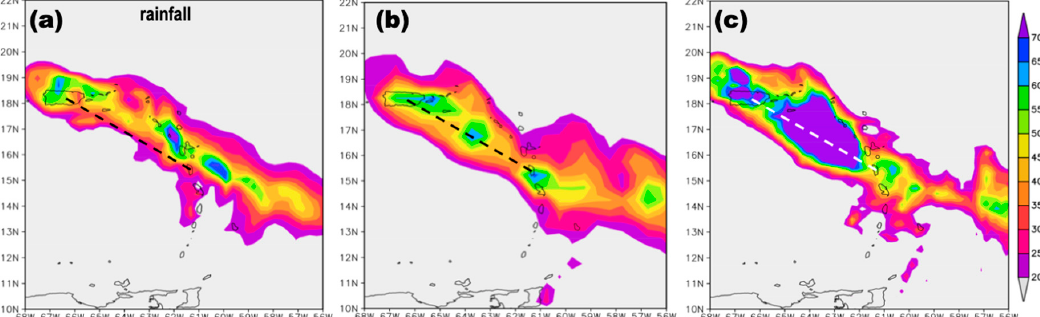
Figure 6. Intercomparison of rainfall estimates averaged 17–20 September from ( a ) ECMWF S-5, ( b ) CMORPH, and ( c ) GPM merged; all with the same scale mm/day. Dashed line connects Dominica and PR for reference.